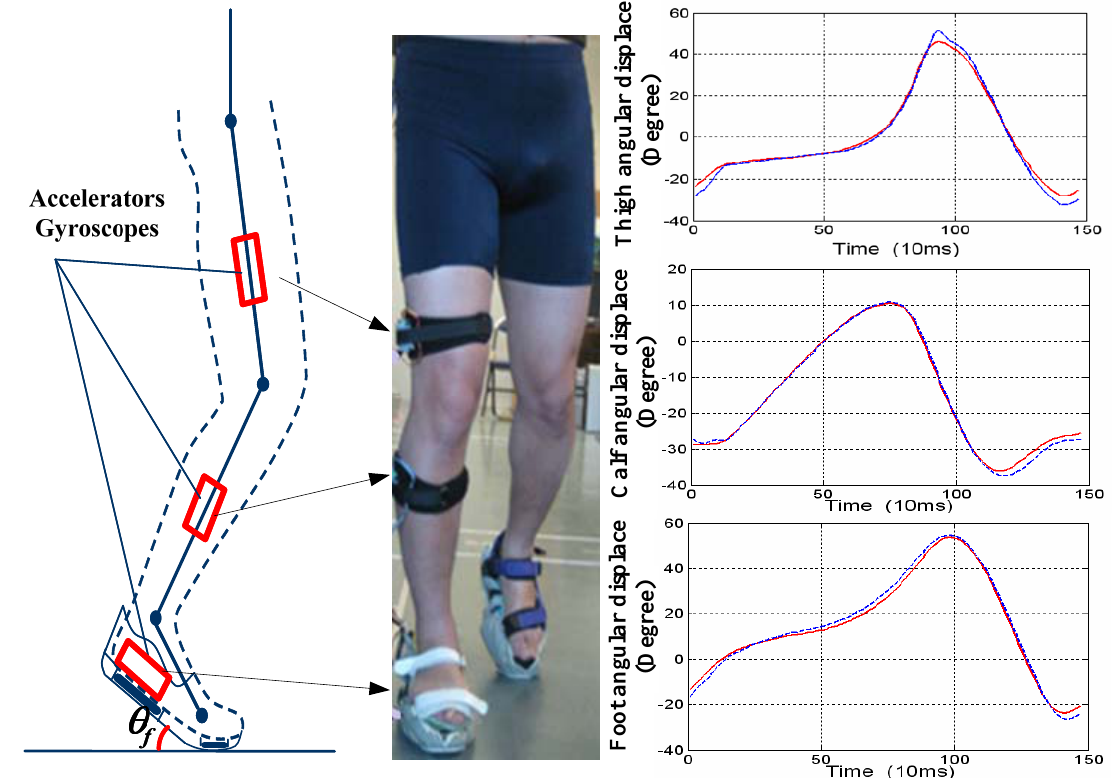
Figure 4. Kinematic measurement based on accelerators and gyroscopes. By using three pairs of accelerators and gyroscopes attached on the foot, calf and thigh seperately, the angular displacements of the lower extremity were